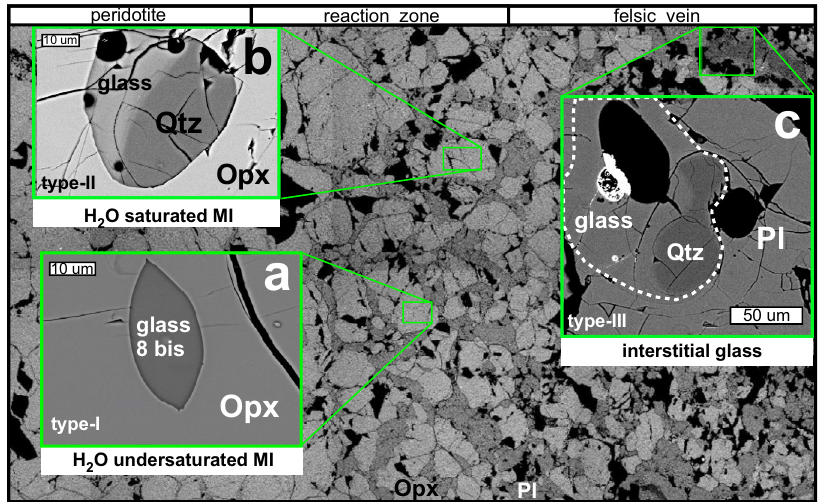
Fig. 1 | Texture of rhyolite inclusions. SEM back scattered electron (BSE) images showing the textures of rhyolite glasses ( a – c ) found in the different portions of the composite xenolith TL112 (large